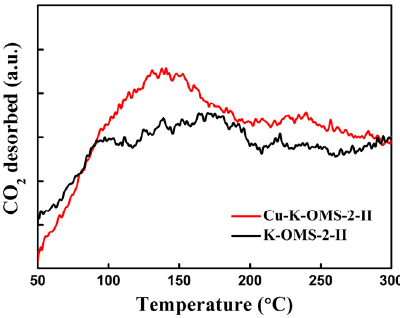
Figure 5. CO 2 -TPD profiles of K-OMS-2 and Cu-K-OMS-2-II. TPD: temperature-programmed desorption.